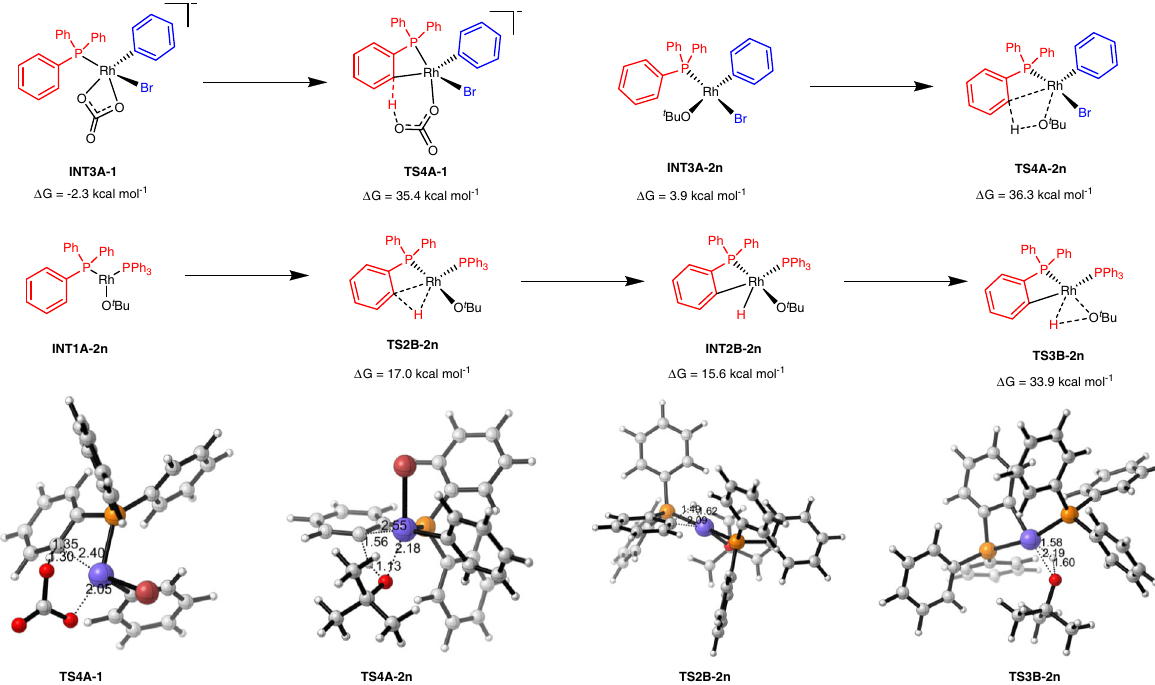
Fig. 9 The effect of t BuOLi in the threefold direct arylation. Energies are in kcal mol − 1 and bond lengths are in